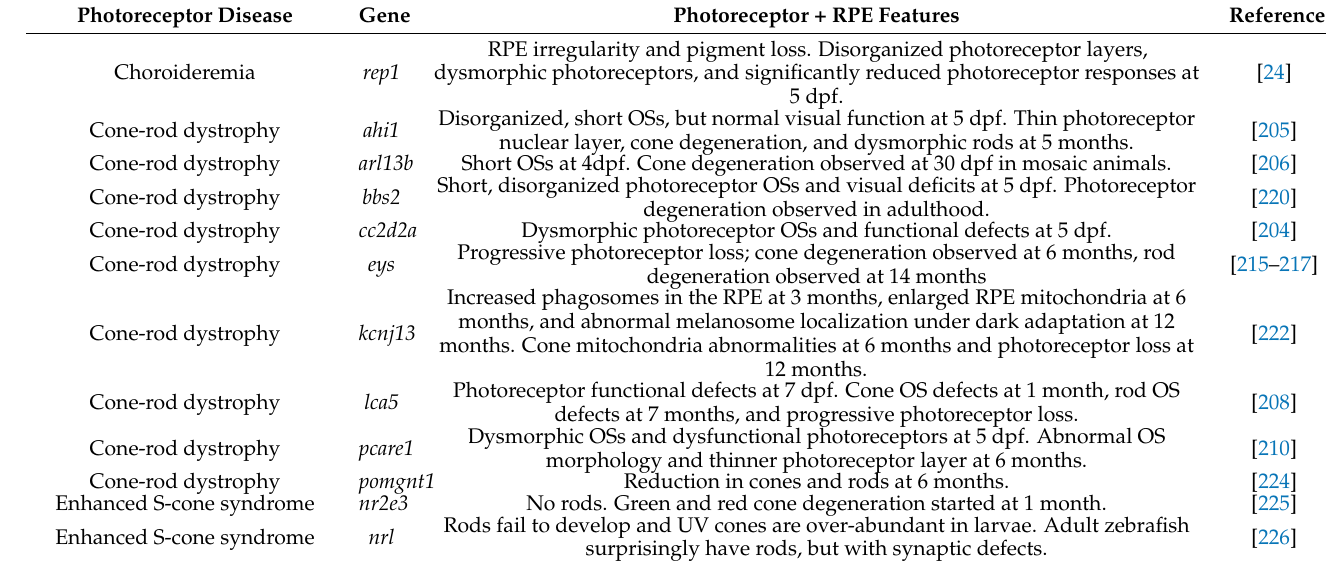
Table 6. Zebrafish mutants of choroideremia, cone-rod dystrophy, and enhanced S-cone syndrome. Photoreceptor Disease Gene Photoreceptor + RPE